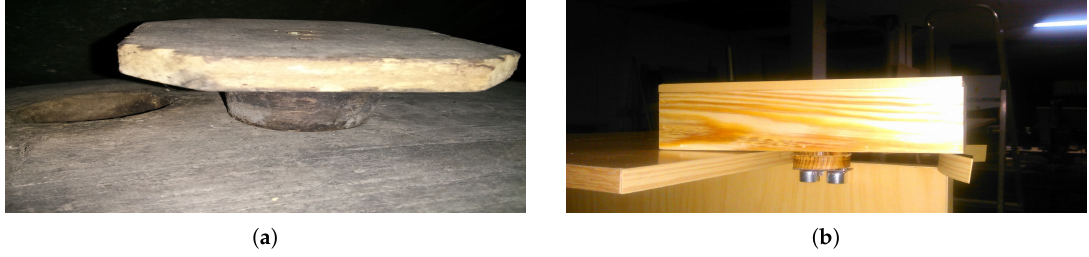
Figure 5. Normal cork vs. the new proposed smart cork. ( a ) Normal Cork; ( b ) smart